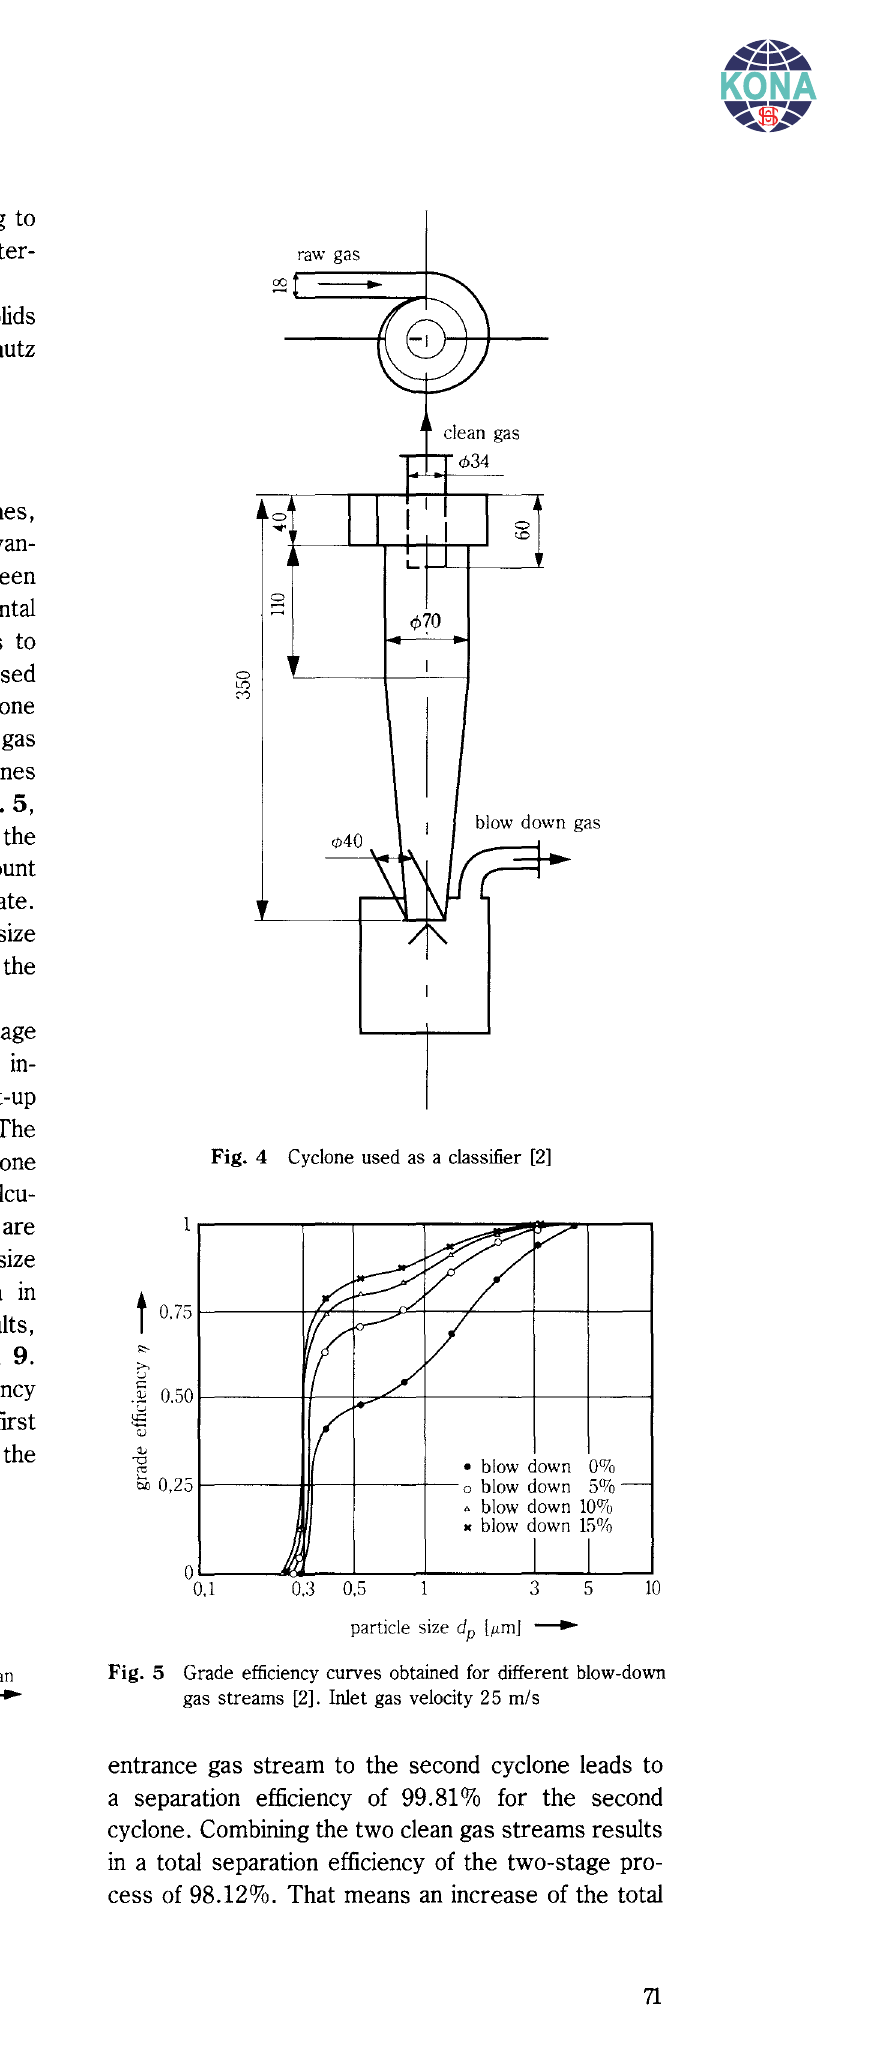
Fig. 5 Grade efficiency curves obtained for different blow-down gas streams [2]. Inlet gas velocity 2 5 m/ s entrance gas stream to the second cyclone leads to a separation efficiency of 99.81 o/o for the